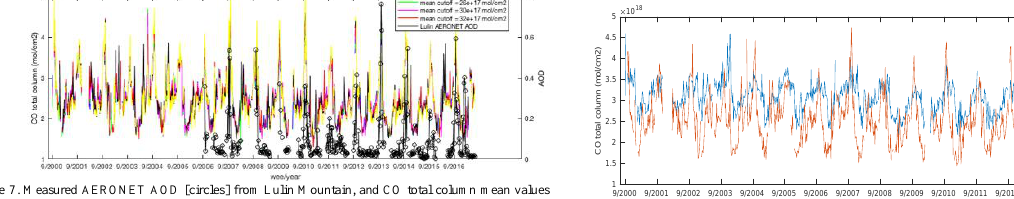
Figure 8. The time series of the mean over urban region and biomass burning region While both of these regions have some oscillation over the course of the year, the oscillation in the urban regions is much